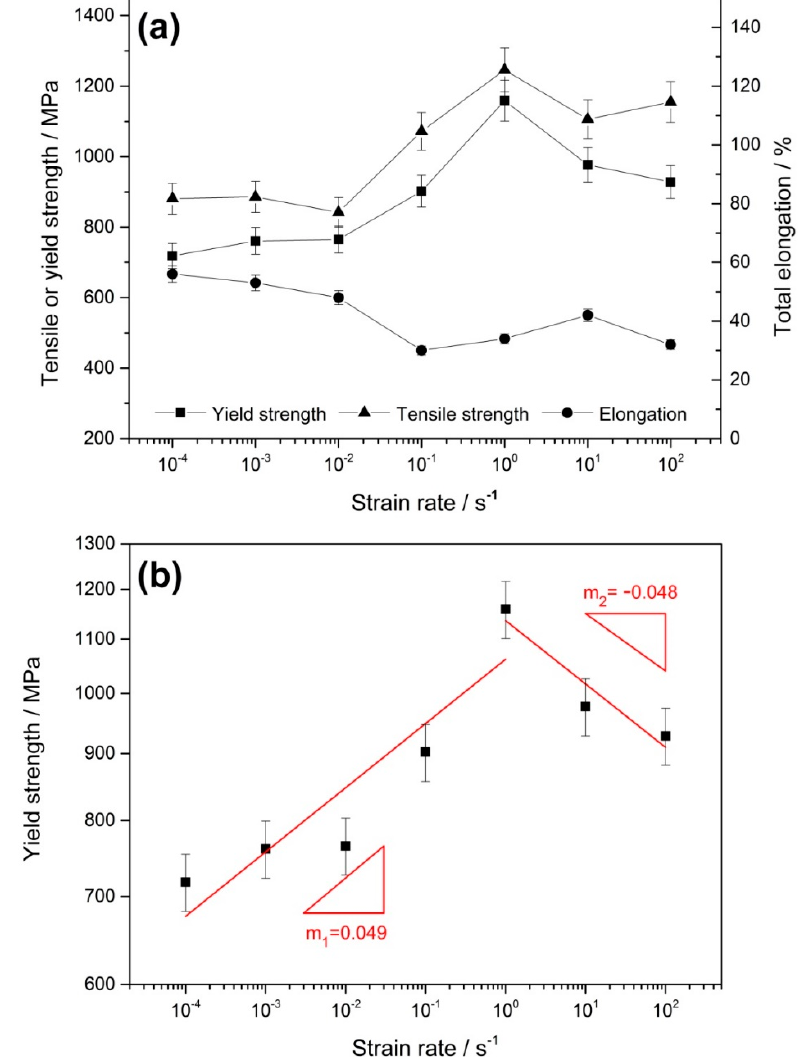
Figure 2. ( a ) The evolution of the mechanical properties of Fe–30Mn–9Al–1C steel at various strain rates. ( b ) The strain rate dependence of yield strength plotted in double logarithmic coordinates. The strain rate sensitivity is 0.049 (m 1 ) at 10 − 4 –10 0 s − 1 and − 0.048 (m 2 ) at 10 0 –10 2 s − 1 .